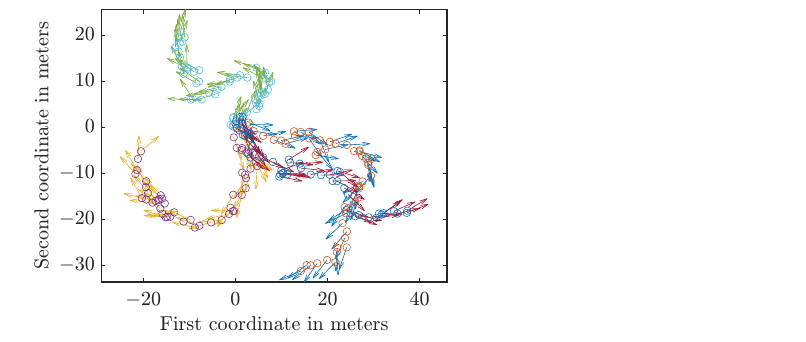
Figure 5. Sample trajectories. The circles indicate the positions, the arrows the heading